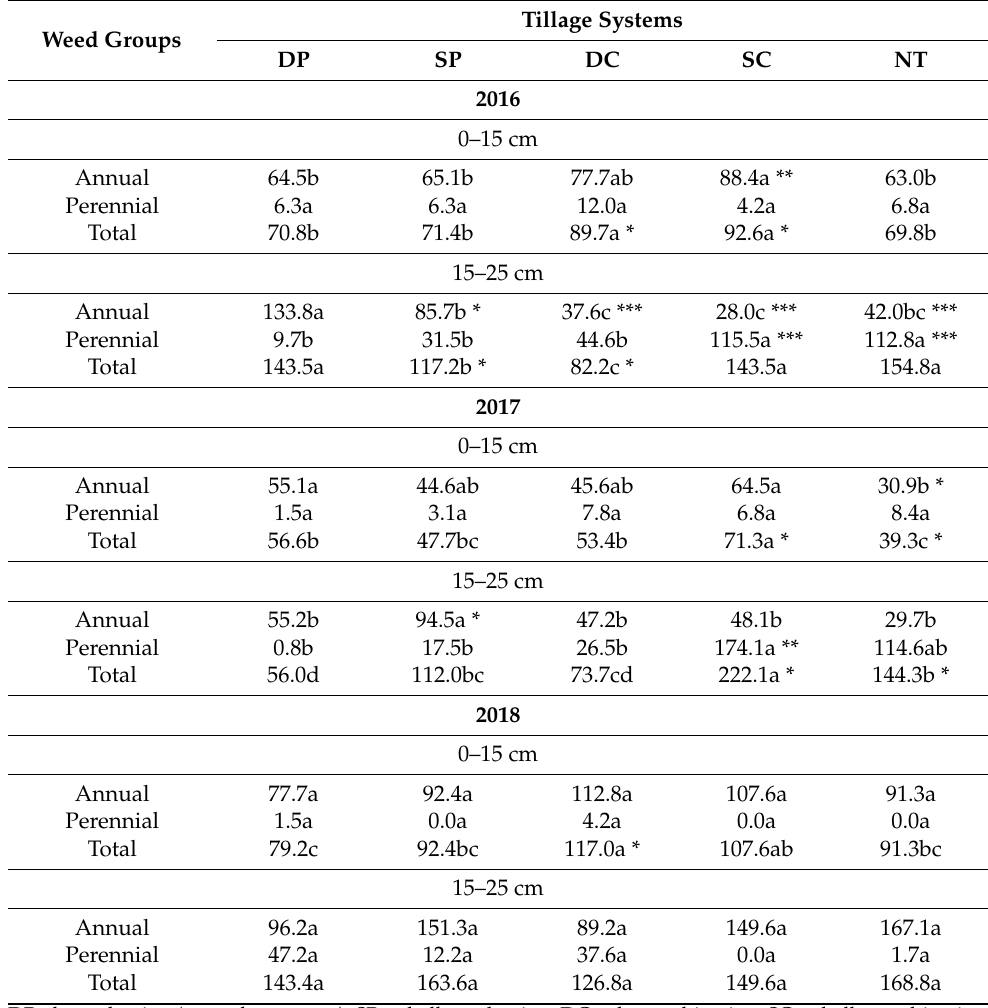
Table 3. Weed seedbank (thousand weed seeds m − 2 ) in different soil layers, as influenced by the tillage system in